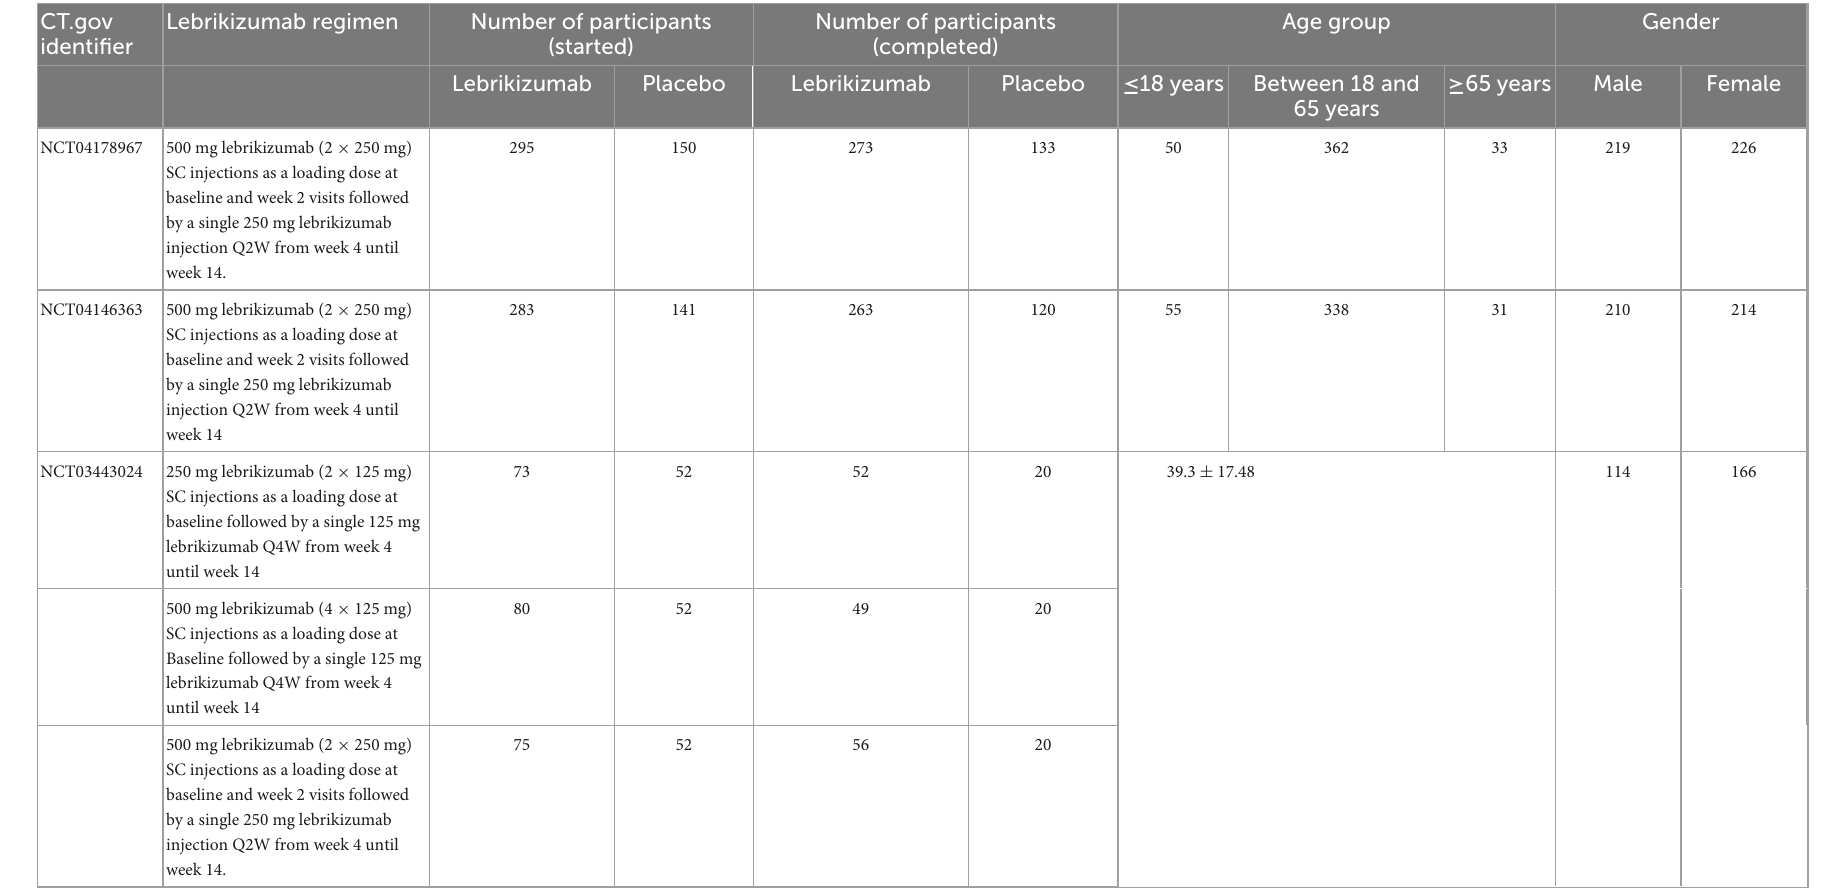
TABLE 1 Characteristics of included